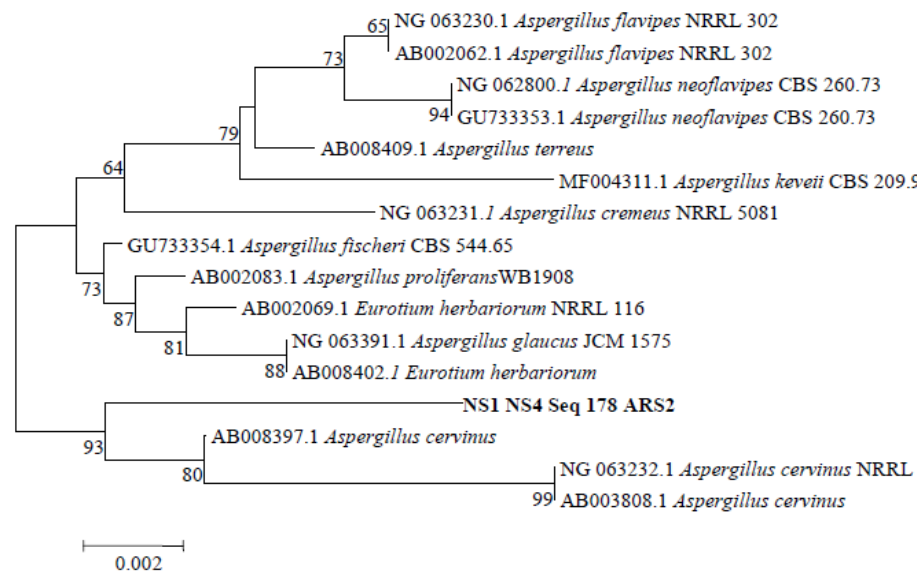
Figure 3. Phylogenetic tree indicating the position of the isolate Aspergillus cervinus ARS2 compared to other species of the genus Aspergillus using 18S rRNA sequencing.